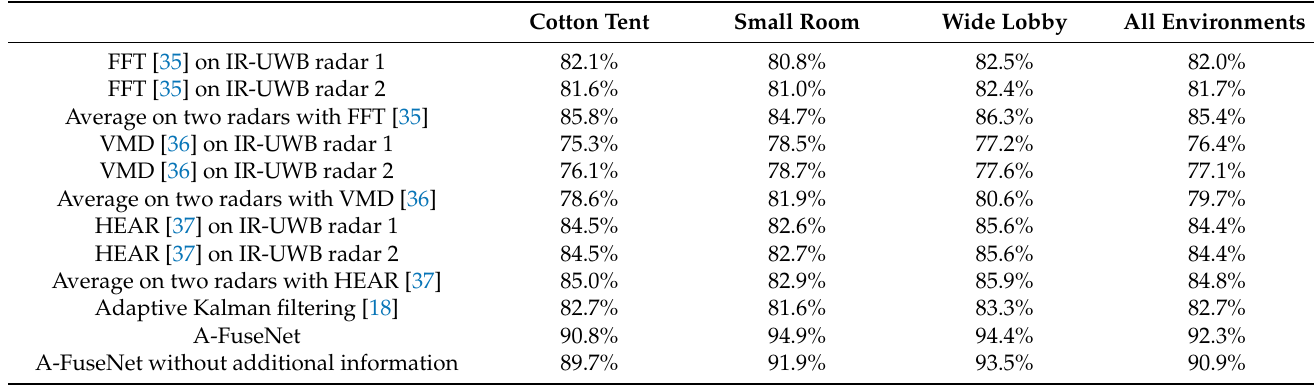
Table 9. Vital sign monitoring accuracy in three indoor environments with different methods. Cotton